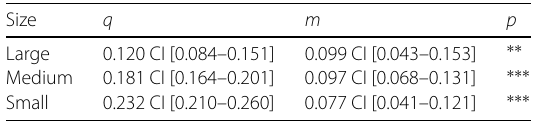
Table 1 Bootstrap results for weekdays. The table reports the mean values of intercept q and slope m for 500 bootstrap iterations. The bootstrapped 95% Confidence Intervals (CI) and the p -value p for the t-test on the slope m ( p ≤ 0.05: ∗ , p ≤ 0.01: ∗∗ , p ≤ 0.001: ∗∗∗ ) are also